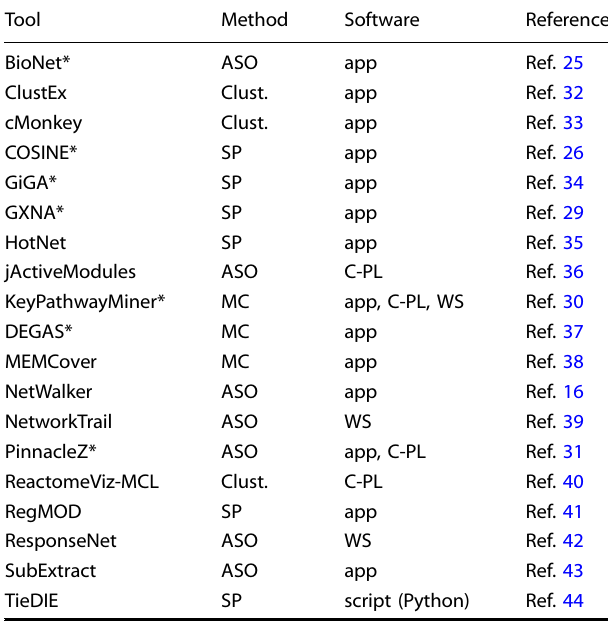
Table 1. List of publicly available de novo network